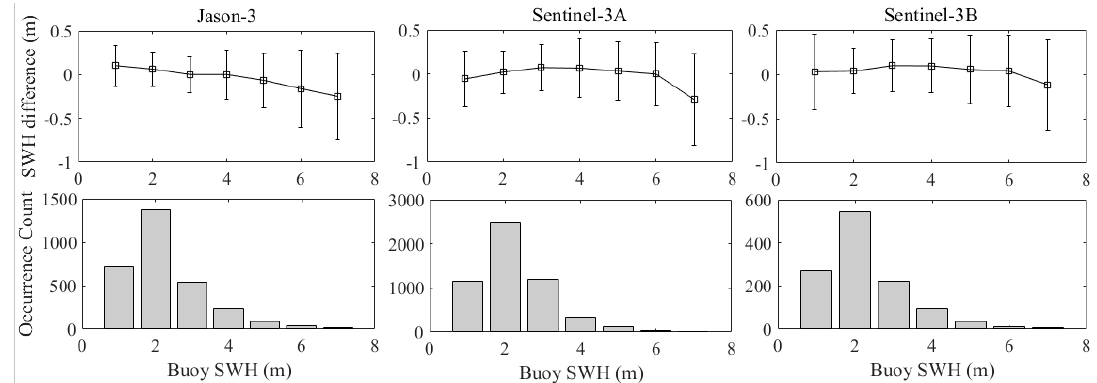
Figure 11. Dependence of the statistical parameters of SWH di ff erences between the Jason-3, Sentinel-3A, and Sentinel-3B altimeters and the NDBC buoys on buoy SWH.